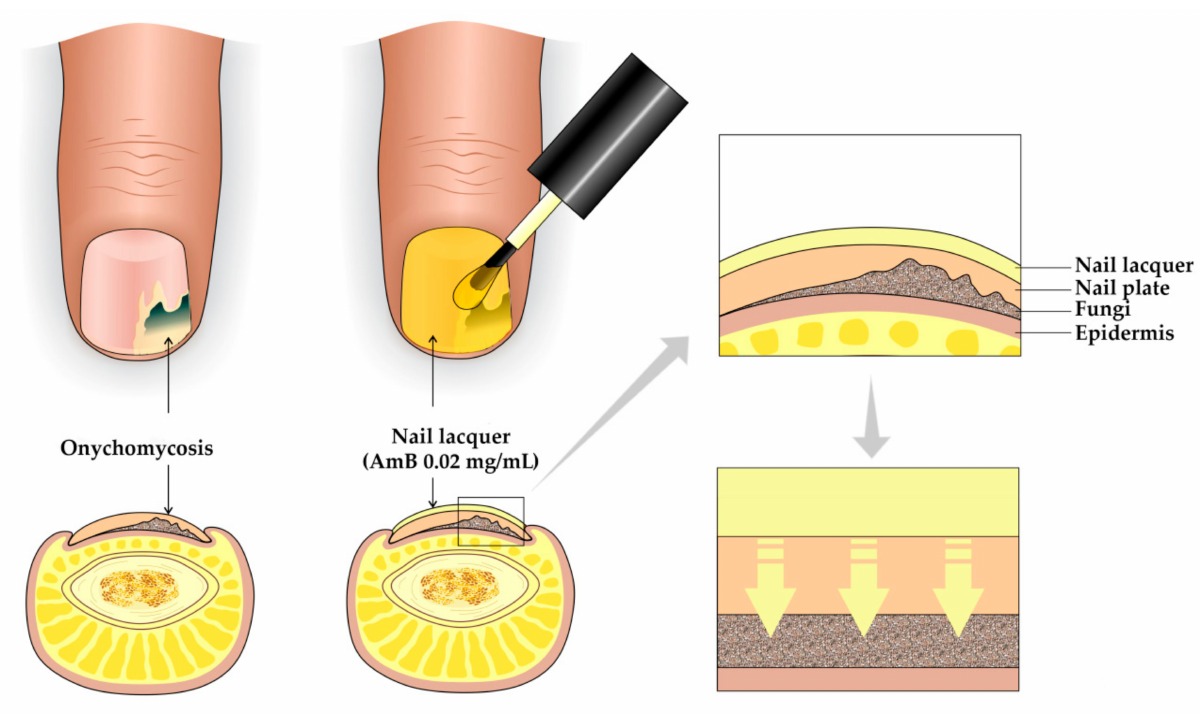
Scheme 1. Overall ungueal anatomy and its correlation to the mechanism of action of nail lacquers for the treatment of